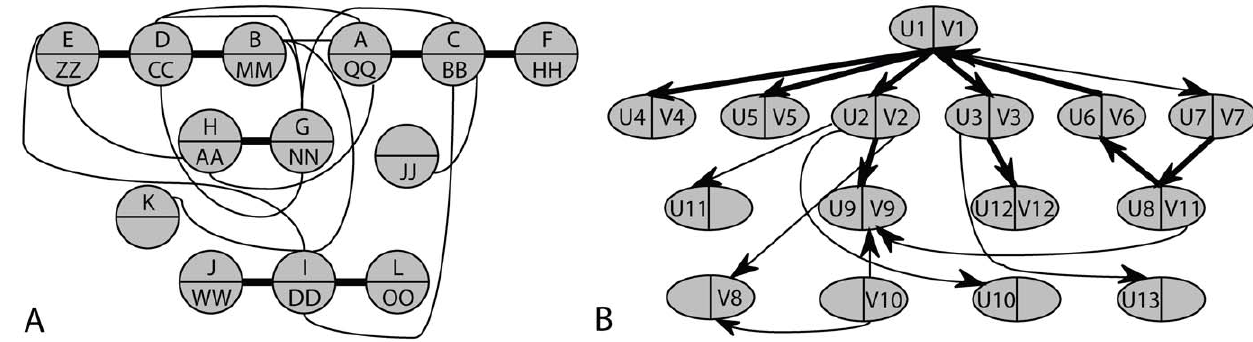
Figure 3. The alignment results for synthetic networks. (A) Undirected networks; (B) Directed networks.